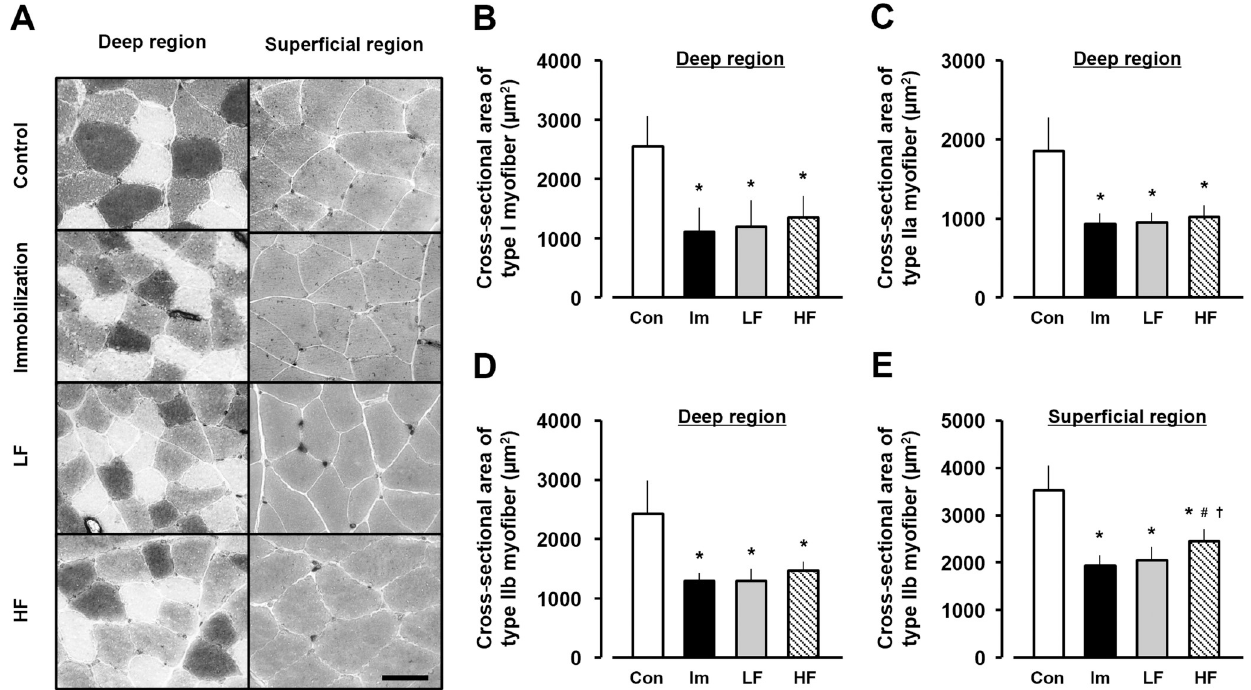
Fig 4. Cross-sectional areas (CSAs) in the deep and superficial regions of gastrocnemius muscles. (A) ATPase staining of gastrocnemius muscle. Black areas, type I fibers. White areas, type IIa fibers. Gray areas, type IIa fibers. Scale bar, 50 μ m. (B) CSA of type I fibers in the deep region. (C) CSA of type IIa fibers in the deep region. (D) CSA of type IIb fibers in the deep region. (E) CSA of type IIb fibers in the superficial region. Open bars, control group (Con). Black bars, immobilization group (Im). Gray bars, LF group. Hatched bars, HF group. Data are presented as mean ± standard deviation. � Significant difference (p < 0.05) compared to the control group #Significant difference (p < 0.05) compared to the immobilization group. †Significant difference (p < 0.05) compared to the LF group. LF, low-frequency; HF, high-frequency.